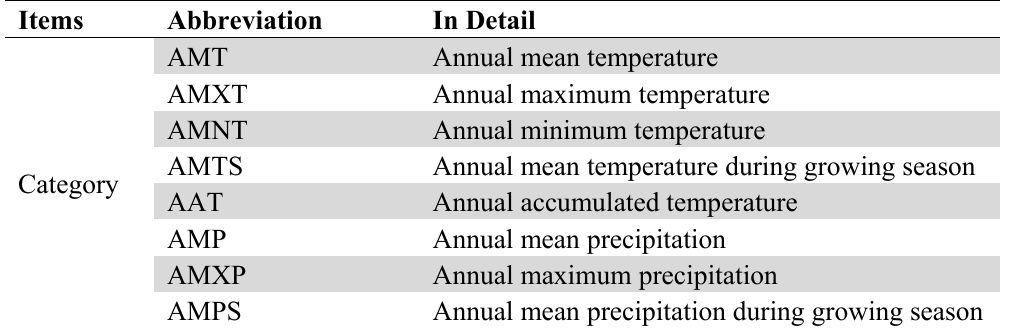
Table 1. Introduction of main climatic